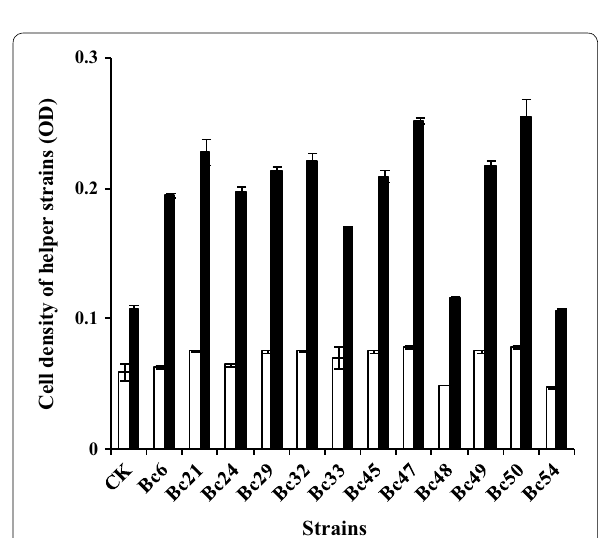
Fig. 4 Determination of cell density of helper strains in the second screening step. Open bar: the OD of helper strain at 0 h of fermenta- tion; filled bar: the OD of helper strain at 12 h of fermentation under the condition of 15% l